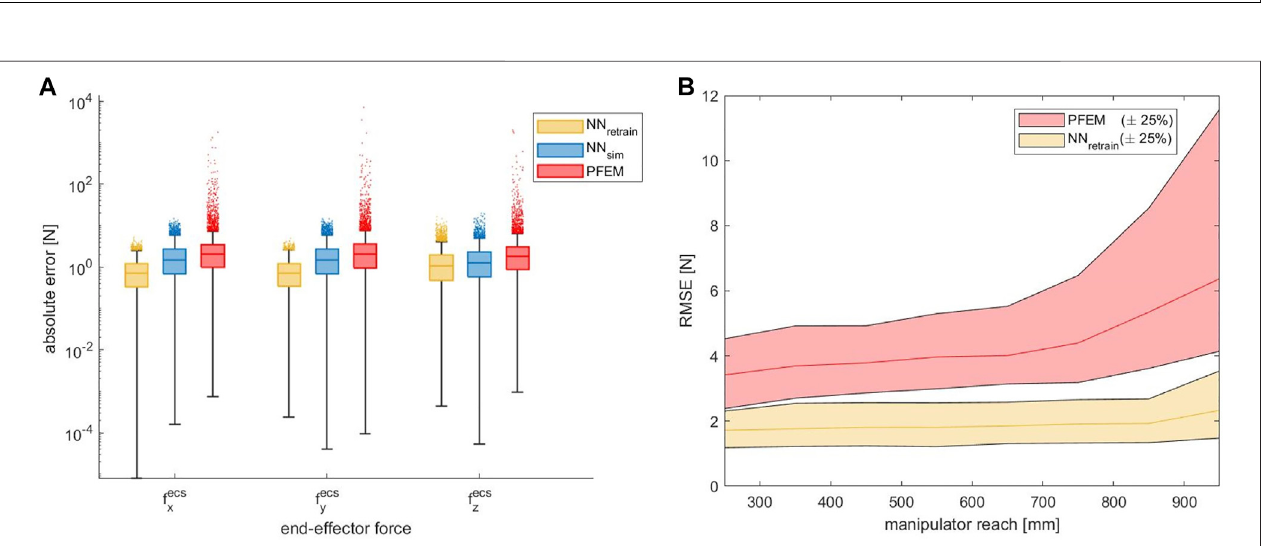
FIGURE 6 | (A) Absolute end-effector force error of the ANN approach compared to the PFEM given for each axis in logarithmic scale, evaluated on the dataset gen , dir . The outliers could be largely reduced by the ANN approaches. (B) Contact force RMSE as a function of increasing manipulator reach in linear scale. A strongly rising error can be observed in the PFEM data from a reach above 700 mm.